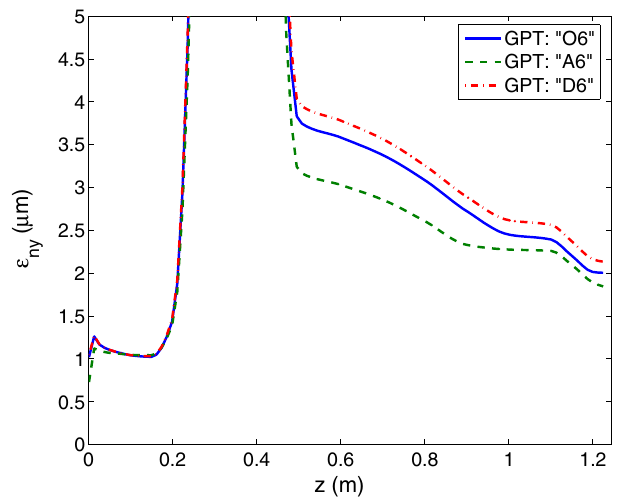
FIG. 10. (Color) Comparison of emittance vs position calcula- tions for GPT with different boundary conditions: open (O6), approximate (A6), and Dirichlet (D6). Refer to the text for details. Bunch charge is 80 pC, the solenoid current is 3.6 A, and the gun voltage is 250 kV. 100k macroparticles were used in the